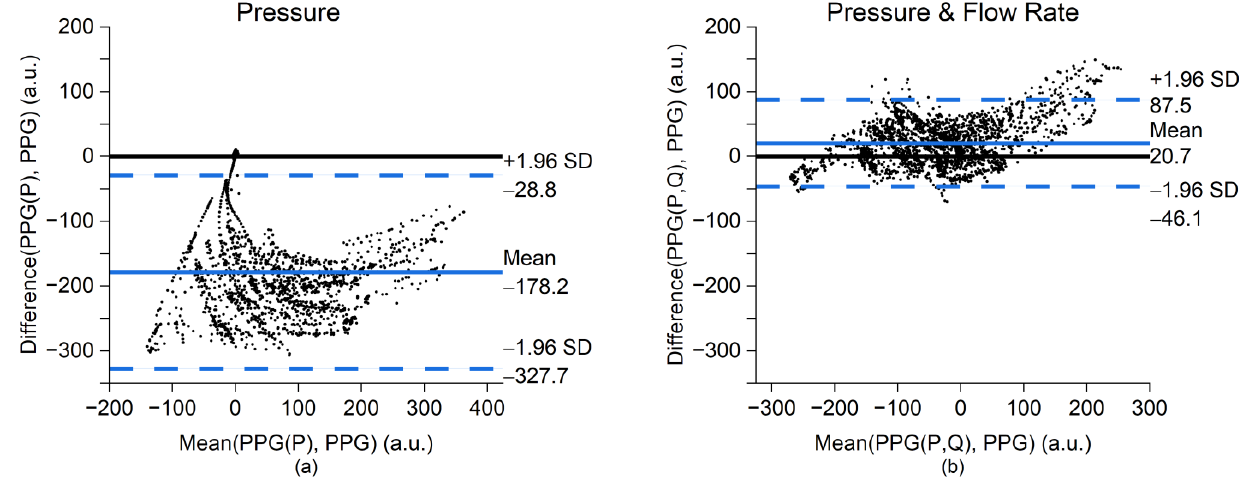
Figure 4. The inclusion of the flow rate dependence of PPG improves prediction accuracy. Bland – Altman plots of the ( a ) predicted instantaneous value of PPG based only on pressure (PPG(P)), and ( b ) based on pressure and flow rate (PPG(P,Q)) versus the measured, instantaneous PPG signal (PPG).